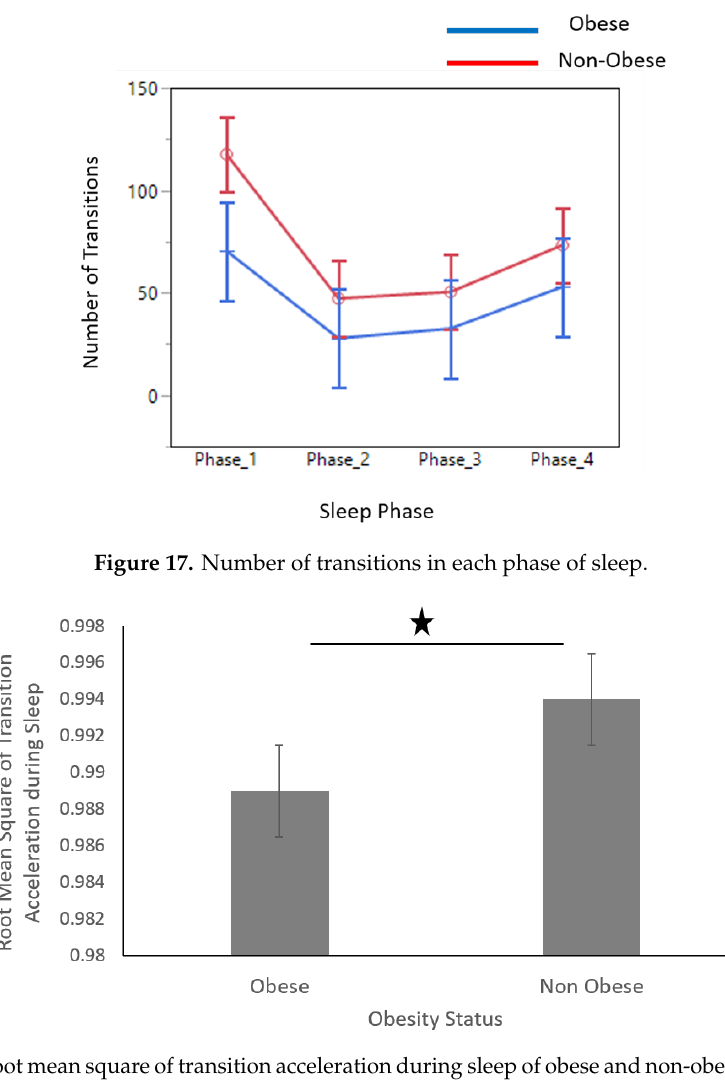
Figure 18. Root mean square of transition acceleration during sleep of obese and non-obese participants.